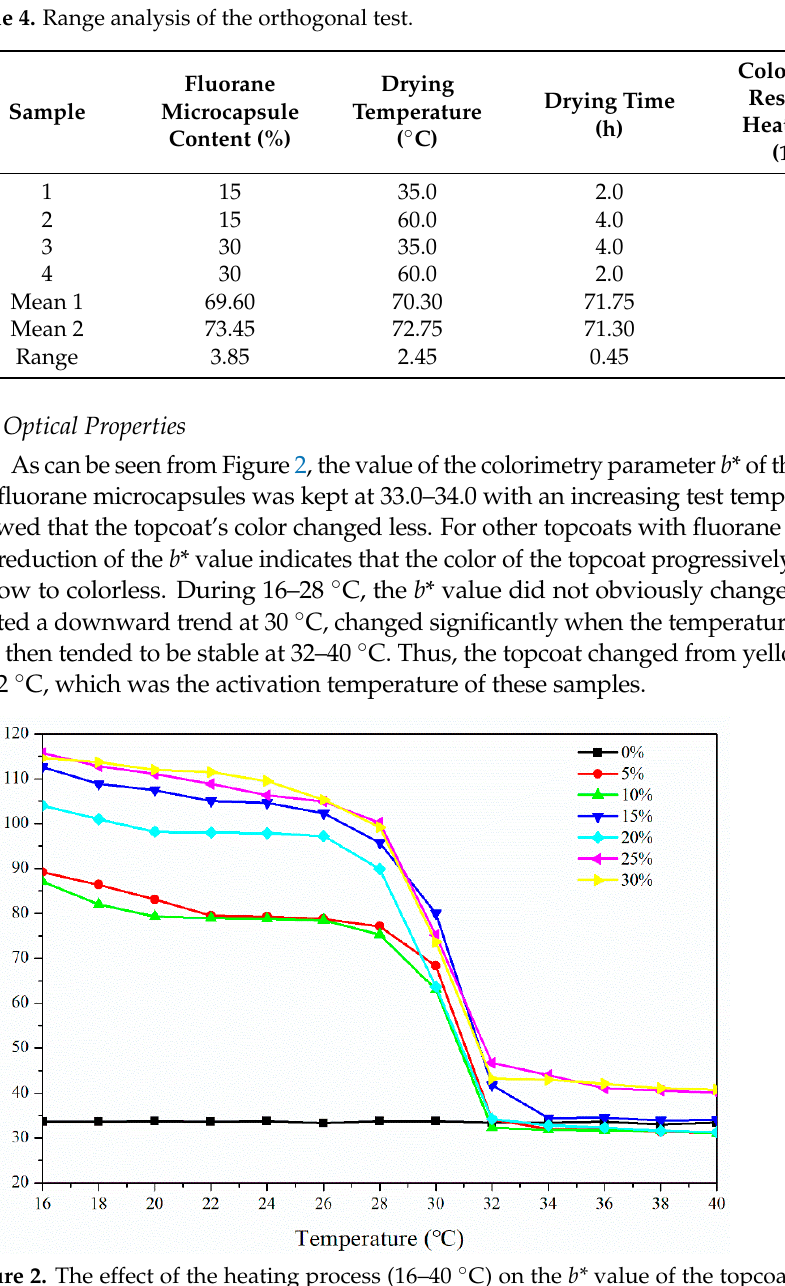
Figure 2. The effect of the heating process (16–40 °C) on the b* value of the topcoat with different contents of fluorane microcapsules.